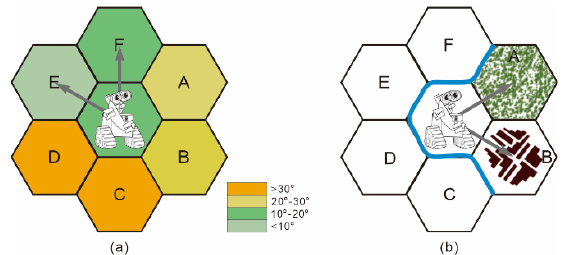
Figure 10. Influence of the grid attributes on robot path planning. ( a ) Influence of the topographic characteristics. Assuming that the robot's climbing ability is 15°, it can only reach grids E and F. ( b ) Influence of the grid element attribute and grid edge attribute. Due to the obstruction of the river, the robot cannot reach grid C, D, E, and F, but it can reach grid A or B. The cost of reaching grid B is less than grid A. Therefore, the robot selects grid B as the next movement route.